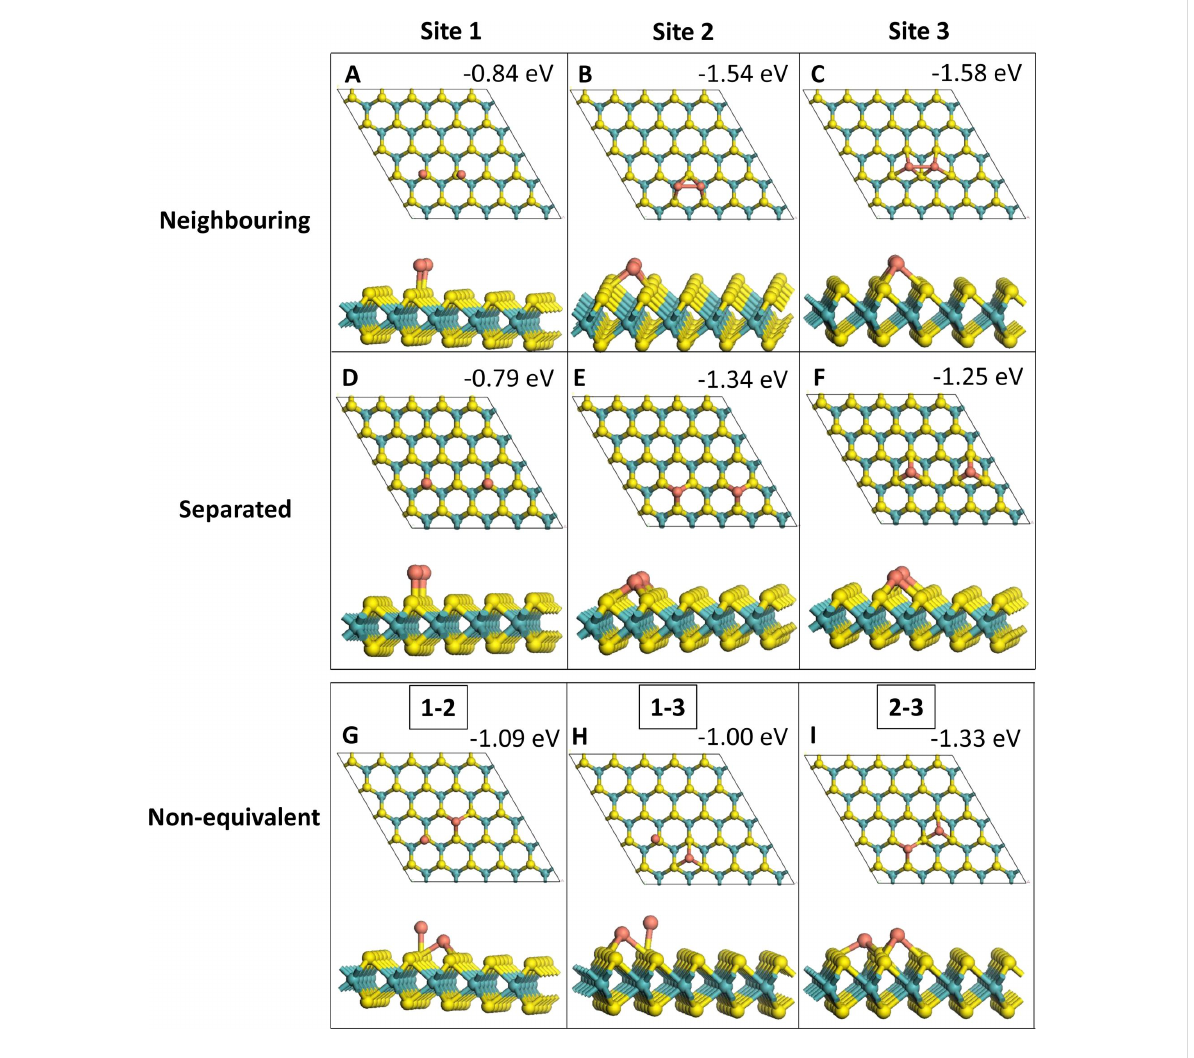
Figure 2: Adsorption configurations with two Cu adatoms. (A) through (F) show adatoms at equivalent sites, while (G), (H) and (I) show combinations of two atoms adsorbed at different sites on the MoS 2 ML.